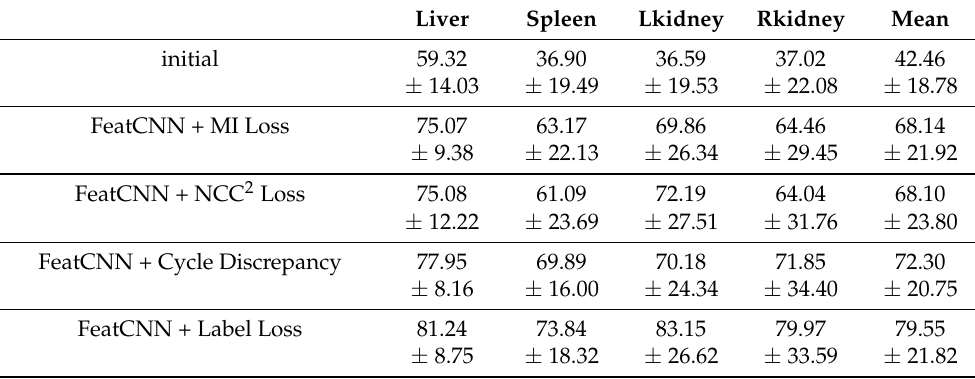
Table 1. Results for our cross-validation experiments: Dice scores listed by anatomical structures of our 3D experiments using FeatCNN for feature extraction and MI Loss, NCC 2 Loss, Label Loss or our Cycle Discrepancy for training.